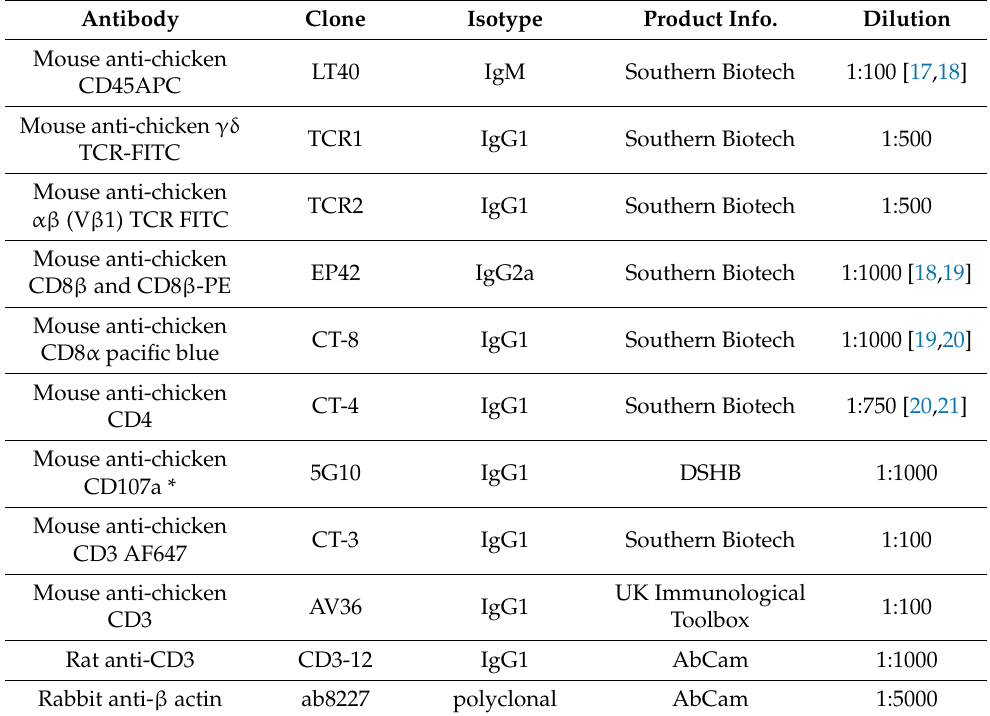
Table 1. Antibodies used for Flow Cytometry and Western Blotting. Antibody Clone Isotype Product